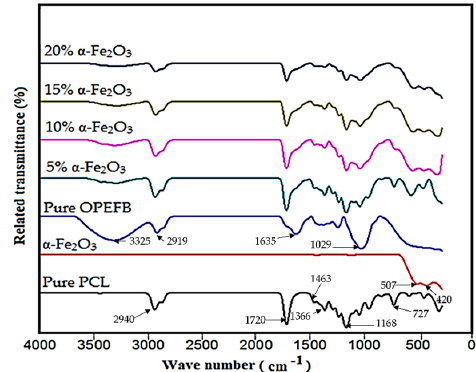
Figure 6. FTIR spectra of pure PCL, recycled α -Fe 2 O 3 , pure OPEFB fiber and α -Fe 2 O 3 /OPEFB/PCL nanocomposites.